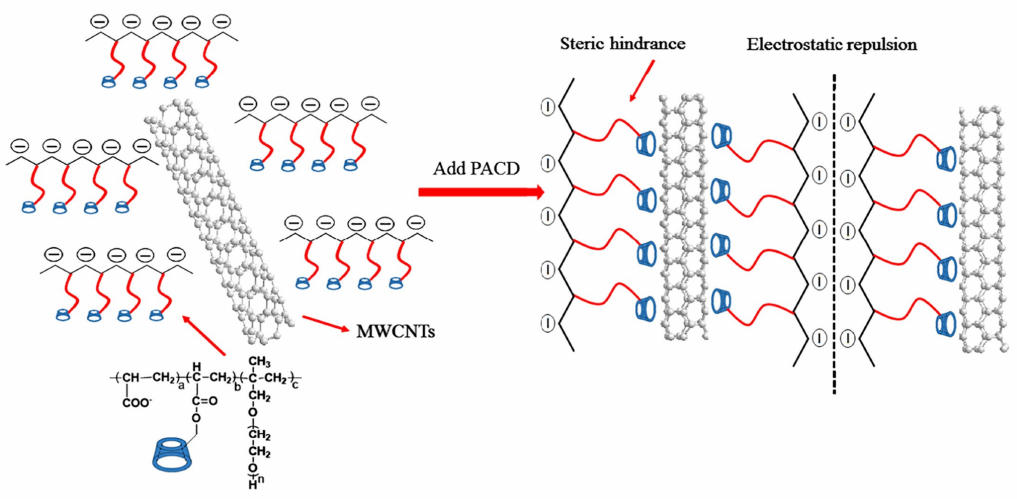
Figure 2. Dispersion mechanism for multiwalled carbon nanotube (MWCNT) with cyclodextrin-modifiedpolycarboxylatesuperplasticizer(PACD).Reproducedfrom[13], withpermission from John Wiley and Sons,